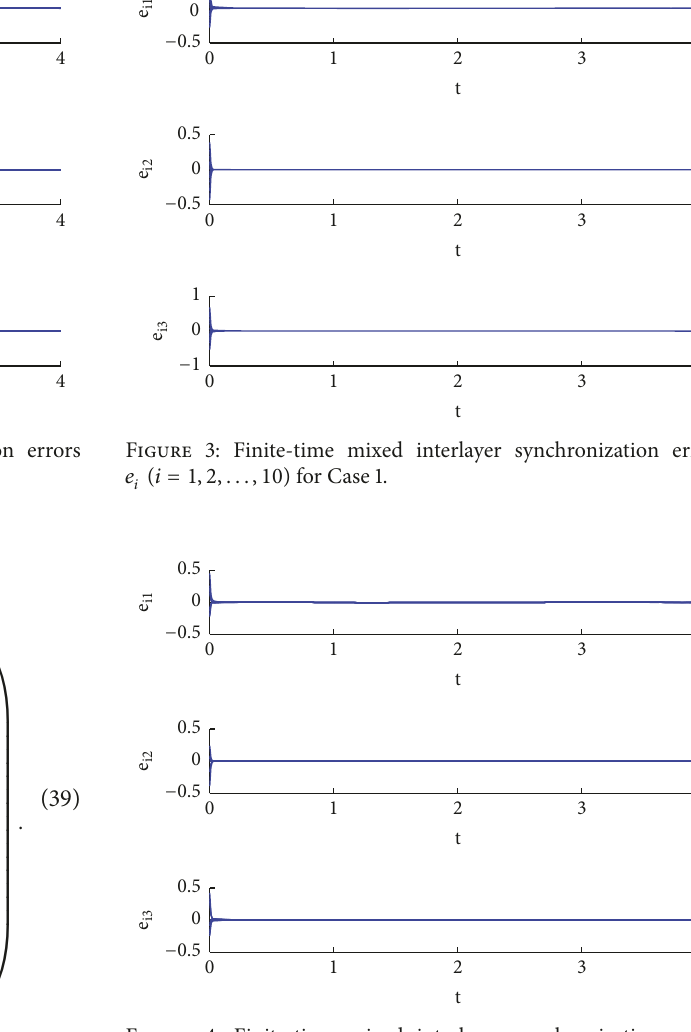
Figure 4: Finite-time mixed interlayer synchronization errors 𝑒 (𝑖 = 1,2,...,10) for Case 𝑖